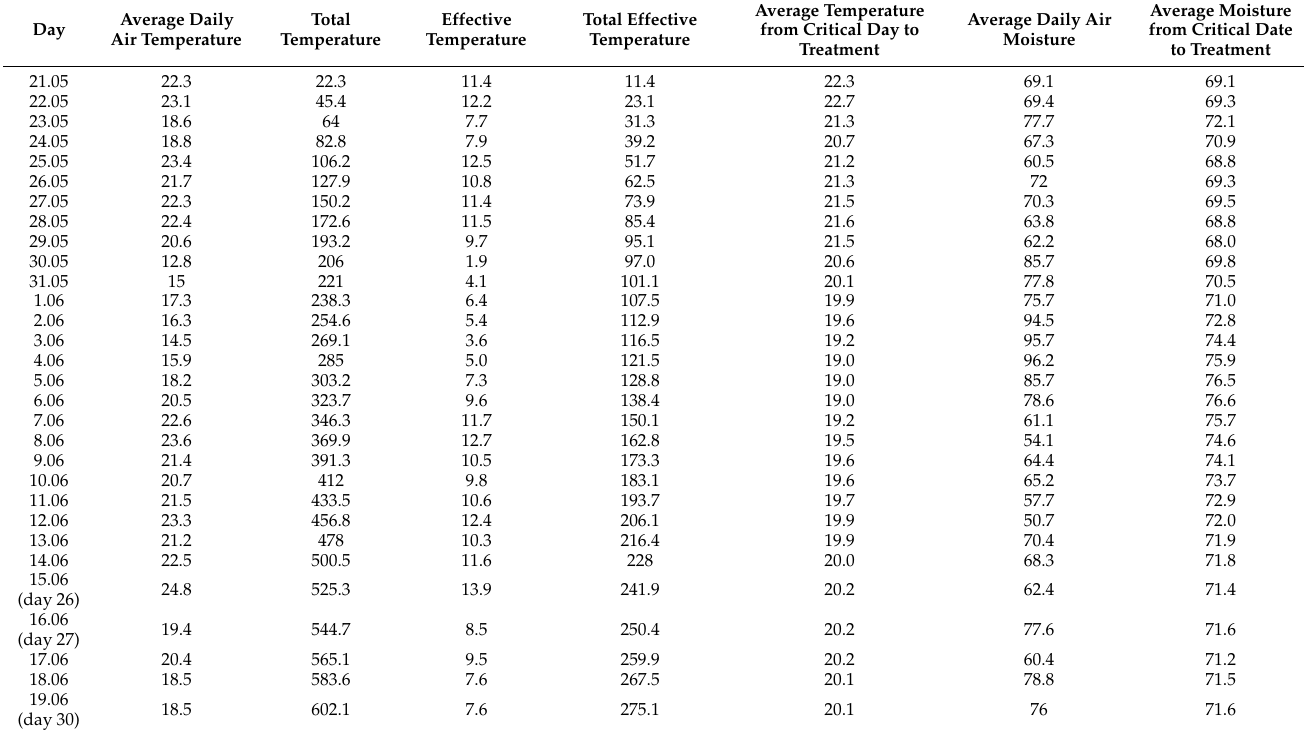
Table 3. Weather data used to arrive at treatment date in Winna G ó ra in